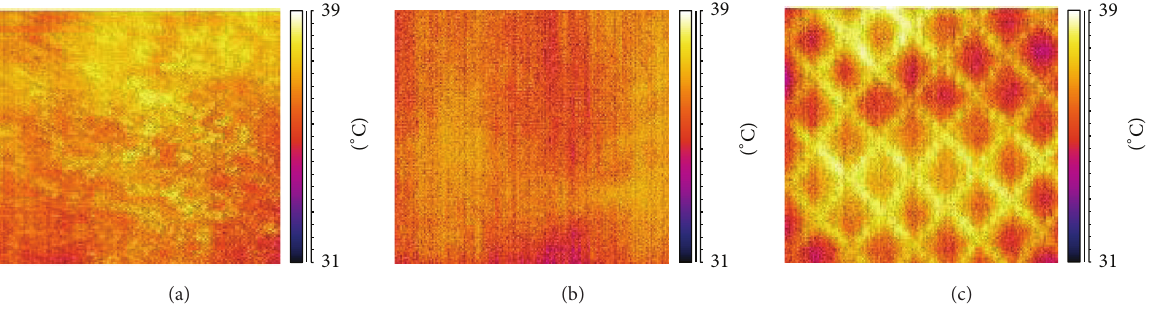
Figure 5: IR images of CO fabrics: (a) plain, (b) satin, and (c) piqu´e.